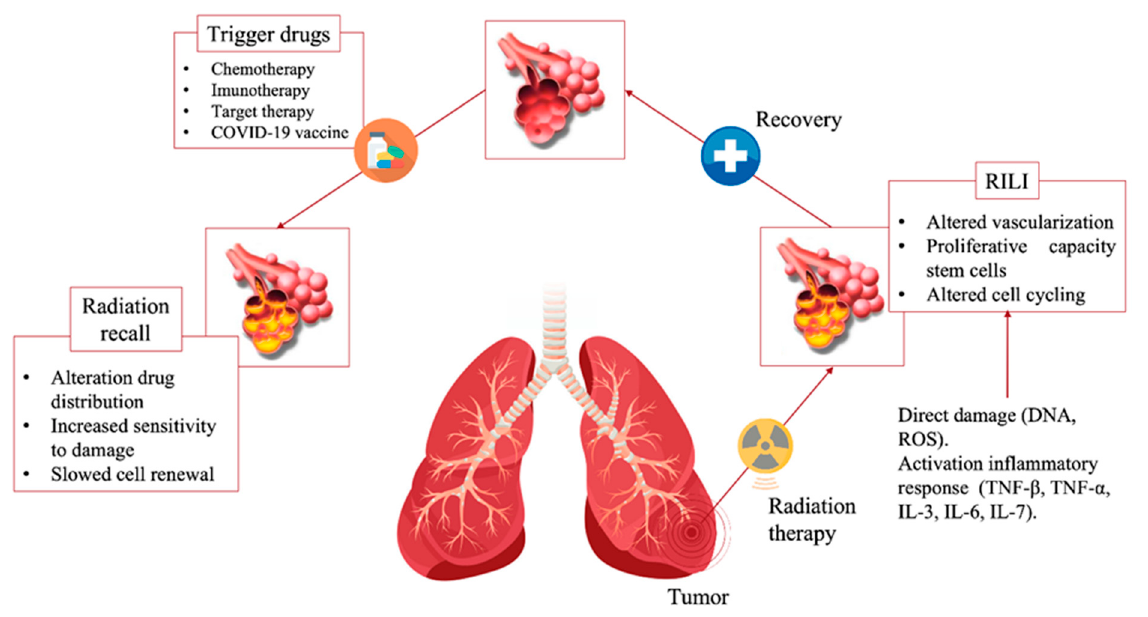
Figure 1. Schematic representation of radiation recall pneumonitis. RILI = radiation-induced lung injury.